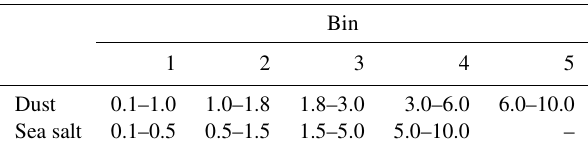
Table 2. Radii ranges (µm) of dust and sea salt bins used in the GOCART aerosol